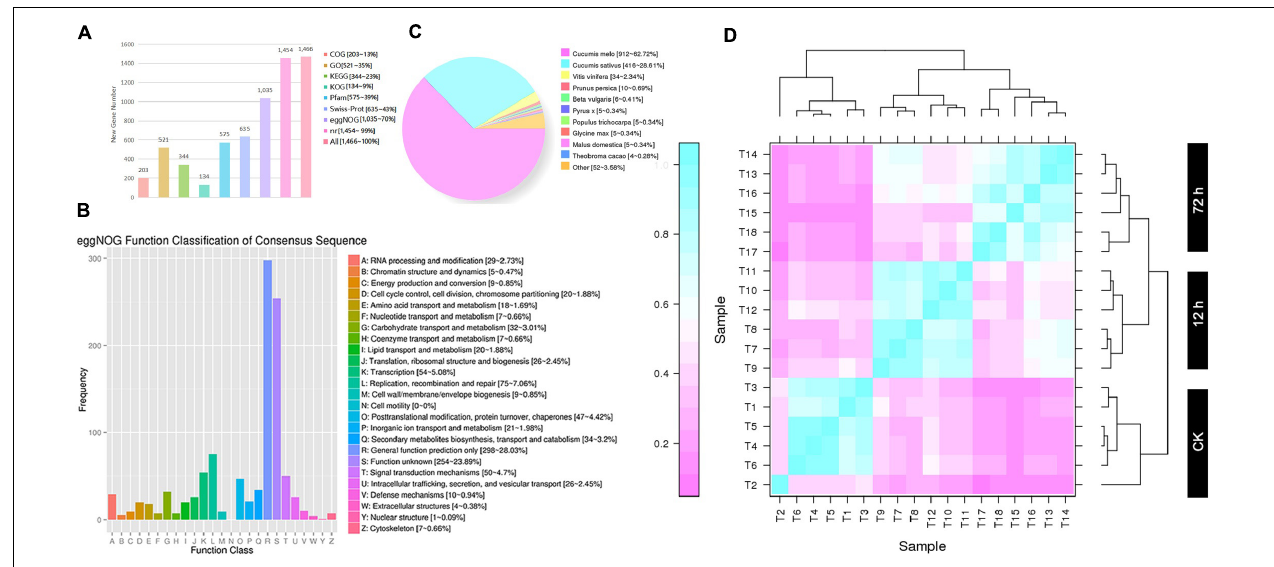
FIGURE 1 | Analysis of new gene annotation and biologically repeated correlation of gene expression among 18 samples. (A) Annotation analysis of multiple databases of new genes. (B) COG annotation analysis. (C) NR annotation analysis. (D) The Heatmap of correlation coefficients of 18 samples (T1-T18) of